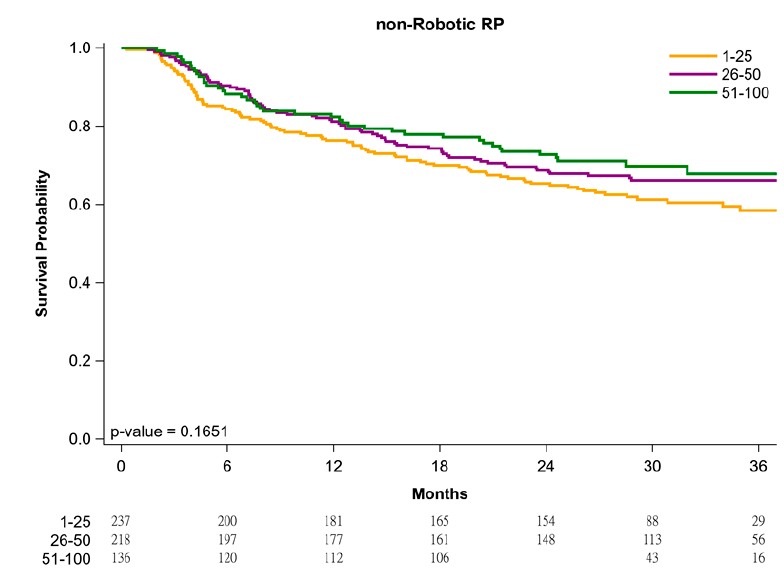
Figure 1. Biochemical failure-free survival curves stratified by hospital volume using robotic ( A ) or nonrobotic ( B ) radical prostatectomy.